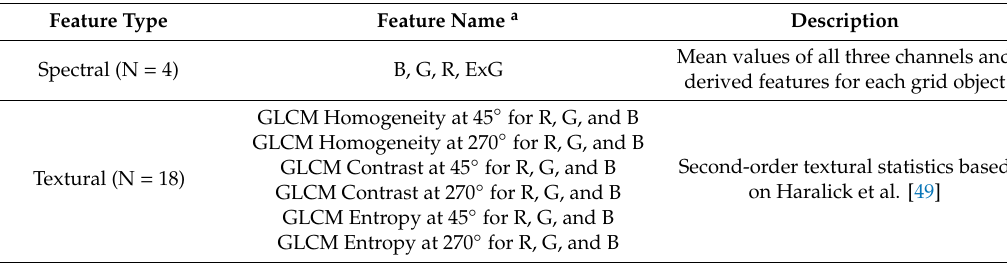
Table 2. Full set of image features tested in the